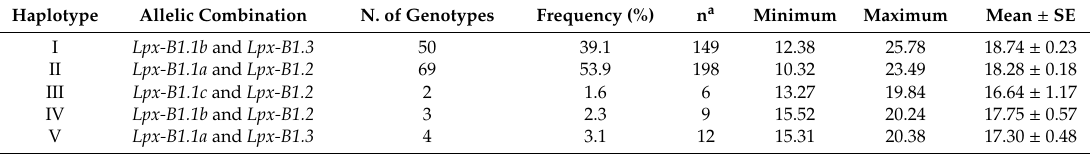
Table 6. Lpx-B1 haplotypes identified in the Mediterranean panel and average b* values across Pirque 2017, Chill á n 2017, and Chill á n 2018. Di ff erences in b* values were not statistically significant ( p > 0.05).